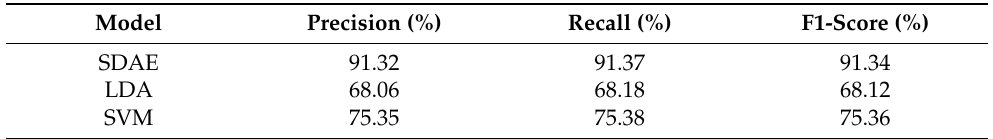
Figure 17. ROC curves of three models. Table 8 demonstrates that compared with the LDA model and the SVM model, the SDAE model has higher accuracy, recall value, and F1 score, indicating that the classifica- tion precision and the sensitivity of the SDAE model are higher.